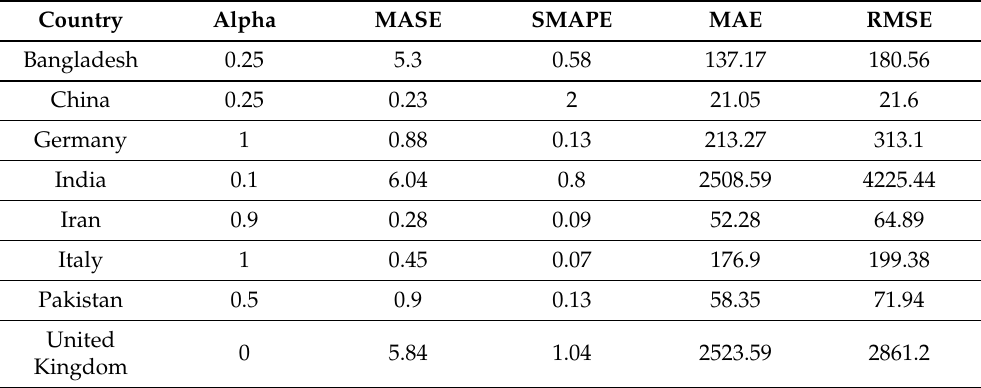
Table 6. Forecasting metrics results of deaths.